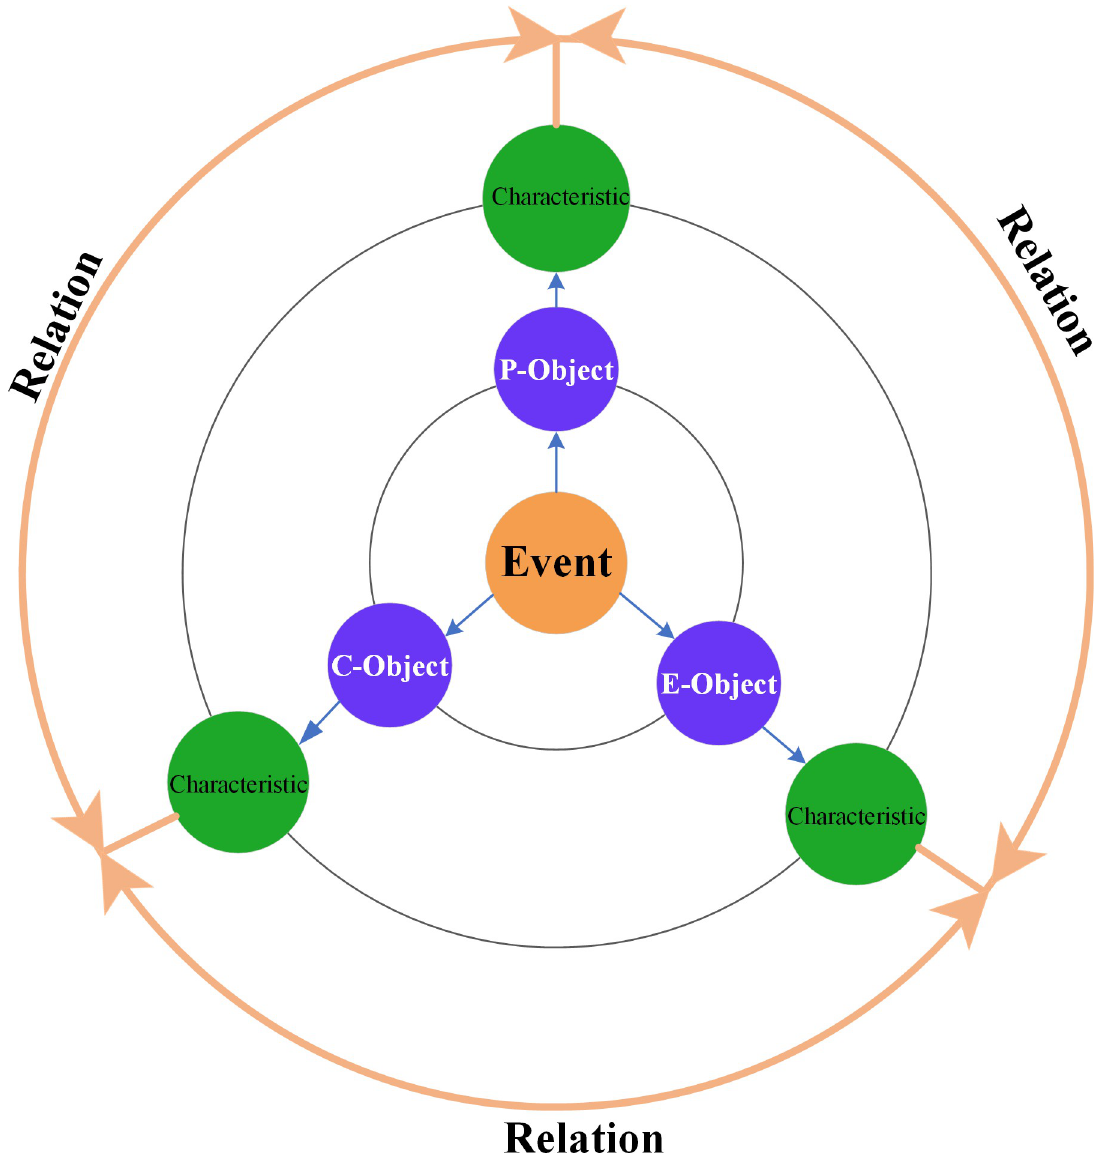
Fig 2. Knowledge representation model of alpine skiing